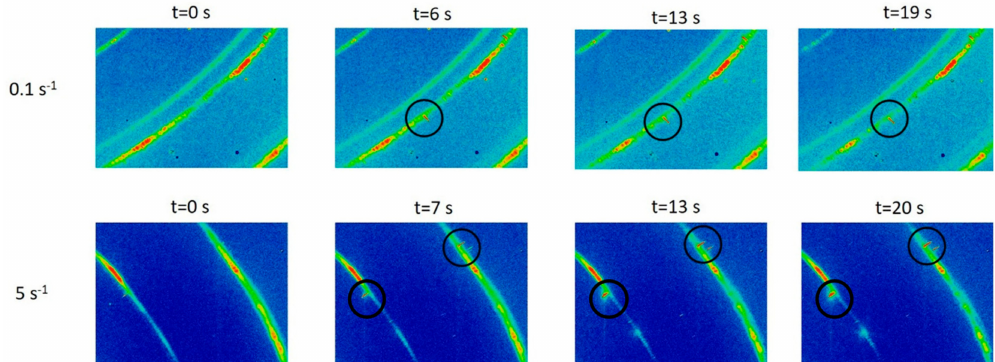
Figure 10. Selected magnified regions of the Debye-Scherrer rings during the first 20 s of isothermal treatment for di ff erent conditions of deformation. The new observed spots (examples enclosed by circles) are indicative of new recrystallized